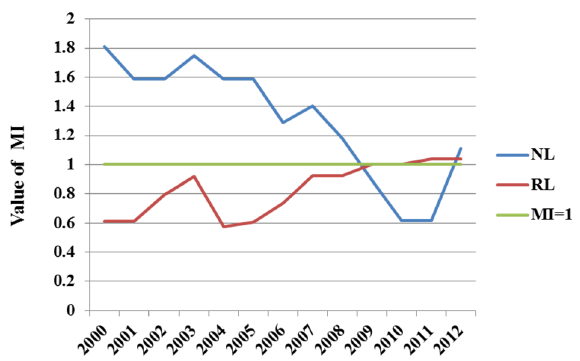
Figure 9. Mutualism index (MI) values of China’s natural gas supply system from 2000 to 2012 for network models on the RLs and NLs.